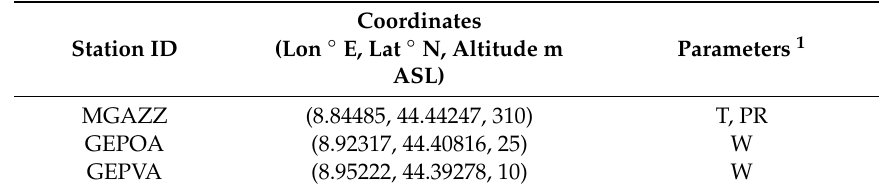
Table 2. Specification of the anemometric stations managed by the Port Authority of Genoa.